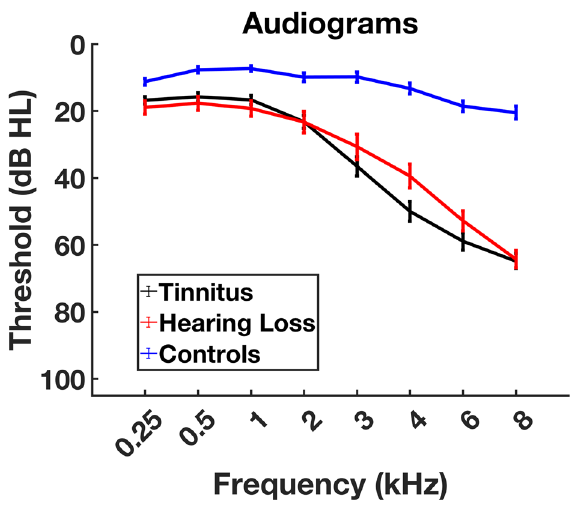
Figure 1. Average hearing thresholds per group with their corresponding standard errors. Pure tone audiometry was used to test octave frequencies from 0.25 to 8 kHz, and 3 and 6 kHz. The two groups with hearing loss, with and without tinnitus, were not significantly different in terms of age (p = .419, t 1.359) and hearing loss [p = .209 (0.25 kHz); p = .3 (0.5 kHz); p = .416 1 (kHz); p = .683 (2 kHz); p = 0.812 (3 kHz); 4 kHz p = .976 (4 kHz); p = .783 (6 kHz); p = .974 (8 kHz)].